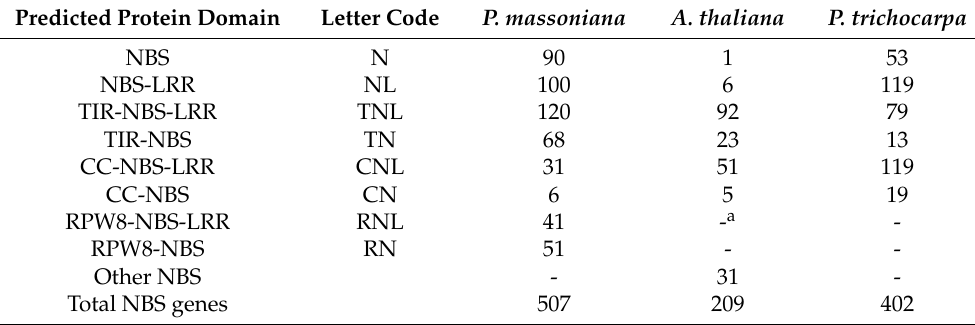
Table 1. Classification and numbers of NBS-related genes in P. massoniana